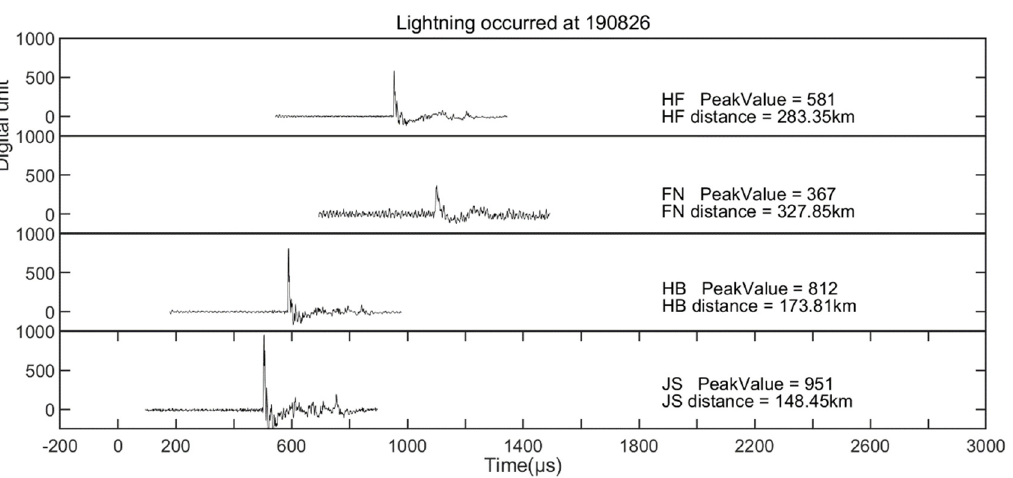
Figure 4. Waveforms of the same CG lightning stroke measured by stations of the Jianghuai Area Sferic Array.